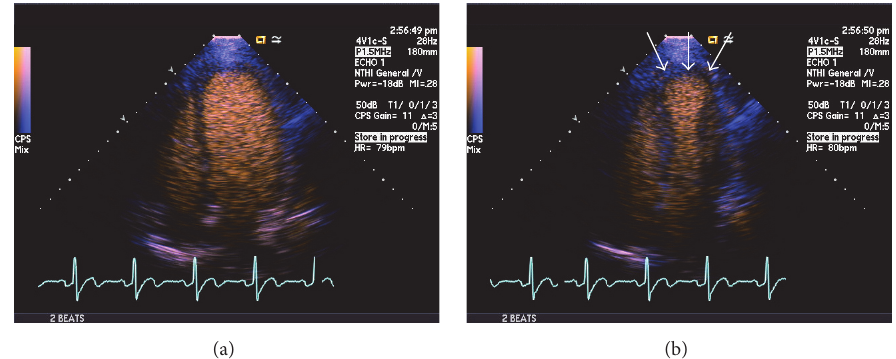
Figure 3: Apical four-chamber echocardiographic images with contrast enhancement at end-diastole (a) and end-systole (b) showing severe akinesis of the left ventricular apex (arrows).